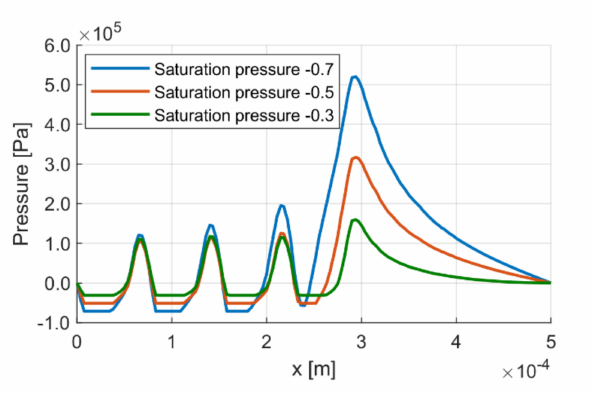
Figure 24. Pressure profiles calculated along the dimples median line at di ff erent saturation pressures. Square dimples with side 50 µ m and gap 3 µ m, sliding velocity 10 m / s. Set A of the cavitation coe ffi cients. The trend for high gap values is due to the di ff erent amount of air that is released;